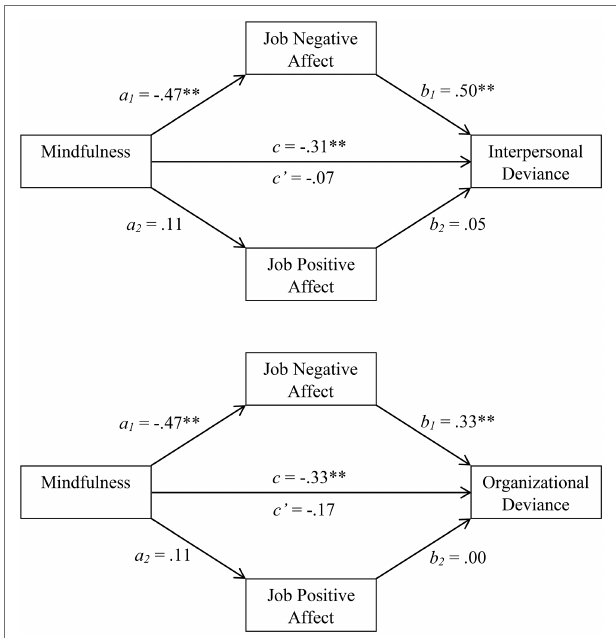
FIGURE 1 | Job affect as a mediator of the relationship between mindfulness and interpersonal deviance ( top panel ) and organizational deviance ( bottom panel ), Study